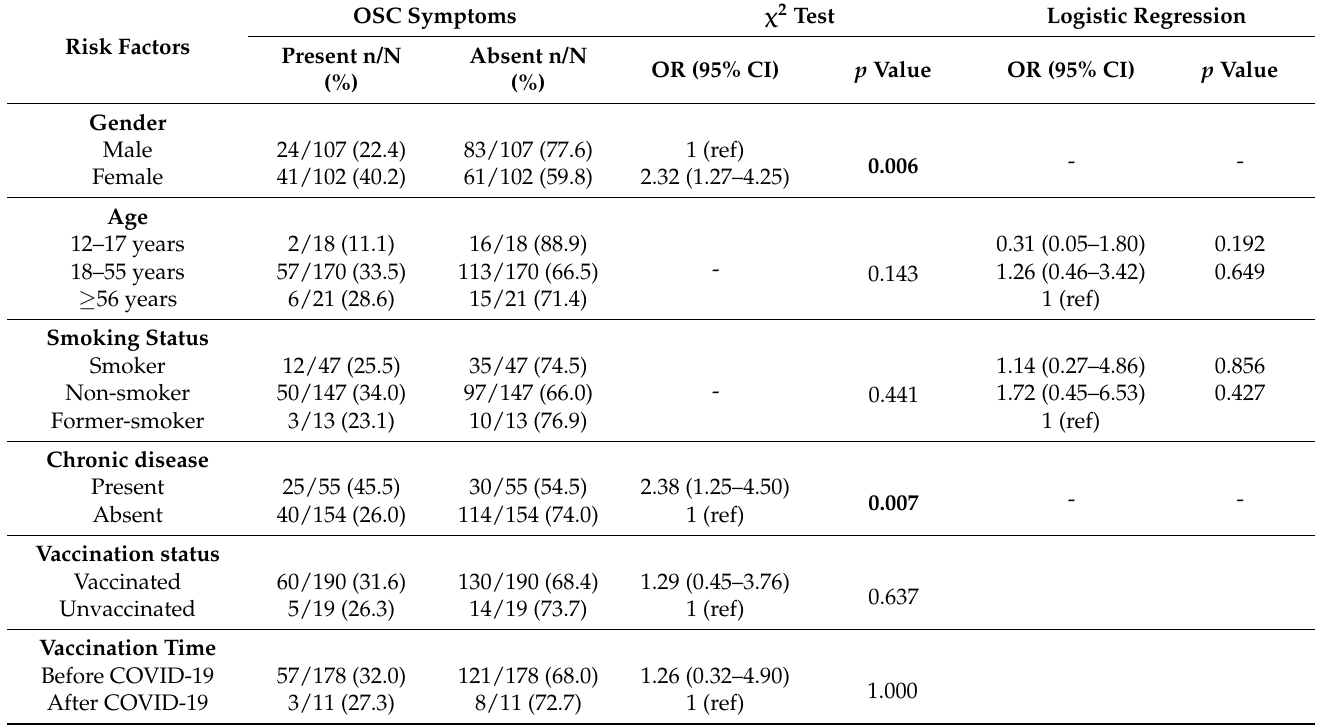
Table 3. Risk factors associated with OSC syndrome in Gr1. Abbreviations: OR, odds ratio; CI, confidence interval; ref, reference value. Significant p values were indicated with bold to assist the